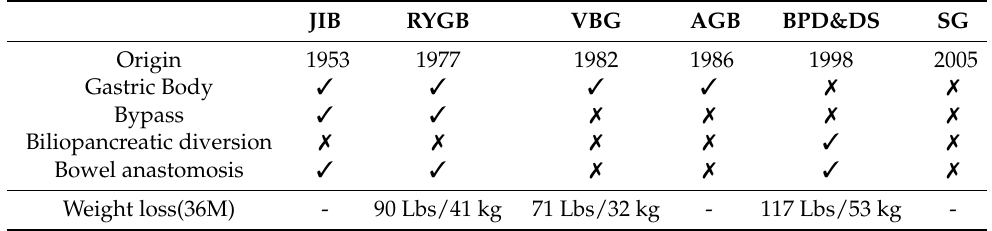
Figure 1. Different types of surgeries: ( A ) jejunoileal bypass surgery (JIB); ( B ) Roux-en-Y gastric bypass (RYGB); ( C ) ver- tical banded gastroplasty (VBG); ( D ) adjustable gastric band (AGB); ( E ): biliopancreatic diversion with duodenal switch (BPD/DS); ( F ) sleeve gastrectomy (SG). Table 1. Different types of surgeries and